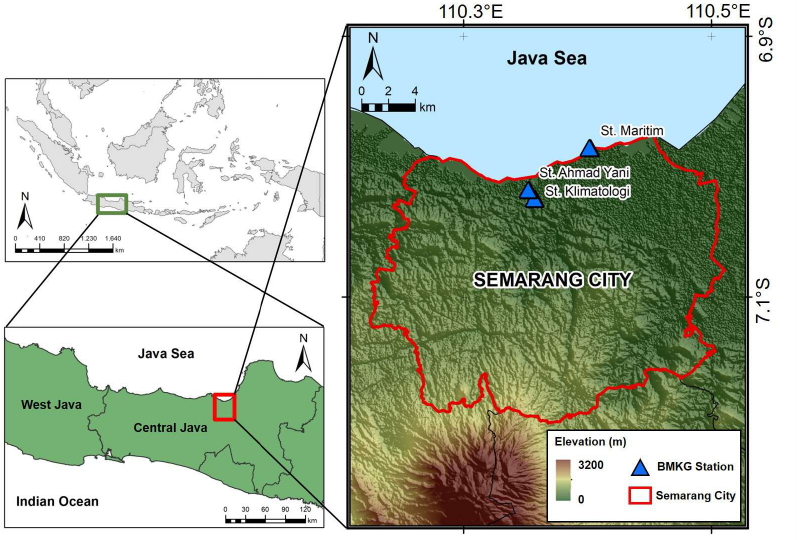
Figure 1. Area of study of Semarang, located in Central Java province of Indonesia. The blue triangle is the rain gauge station that was used in this study. The color shading shows the topography profile. The red line is the administration boundary of